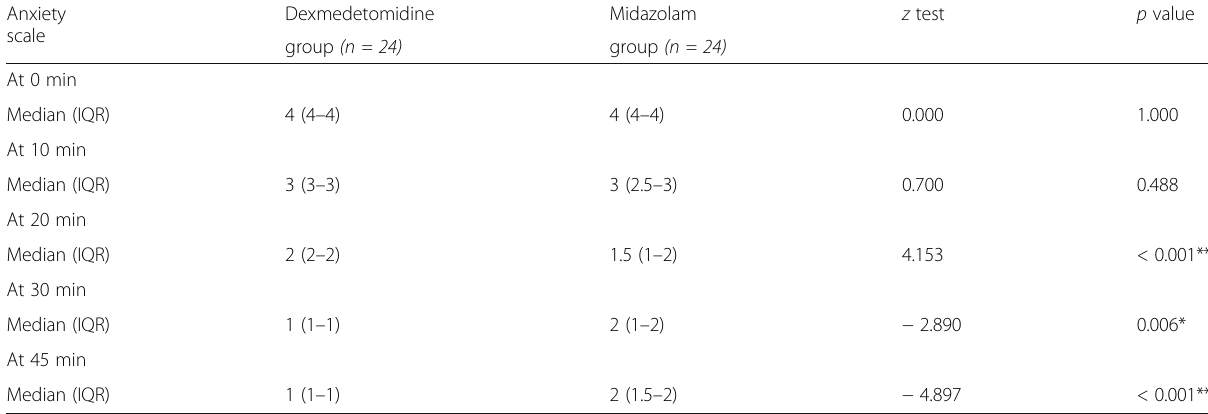
Table 8 Comparison between group D and group M as regards Anxiety scale Anxiety scale